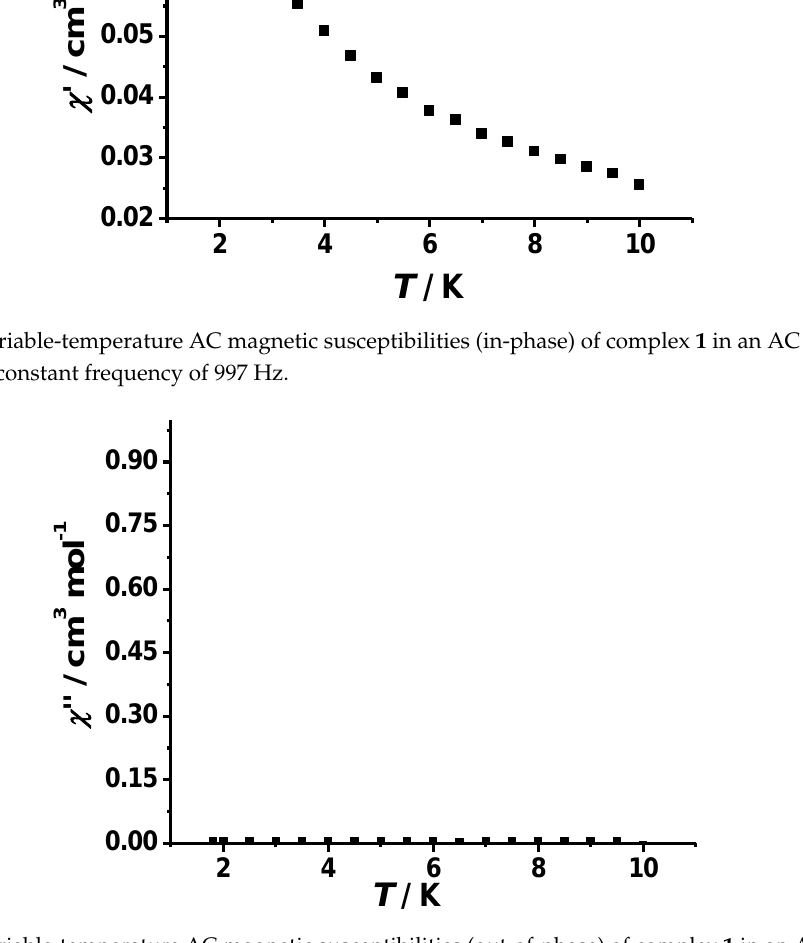
Figure 6. Variable-temperature AC magnetic susceptibilities (out-of-phase) of complex 1 in an AC field of 5 Oe with a constant frequency of 997 Hz.